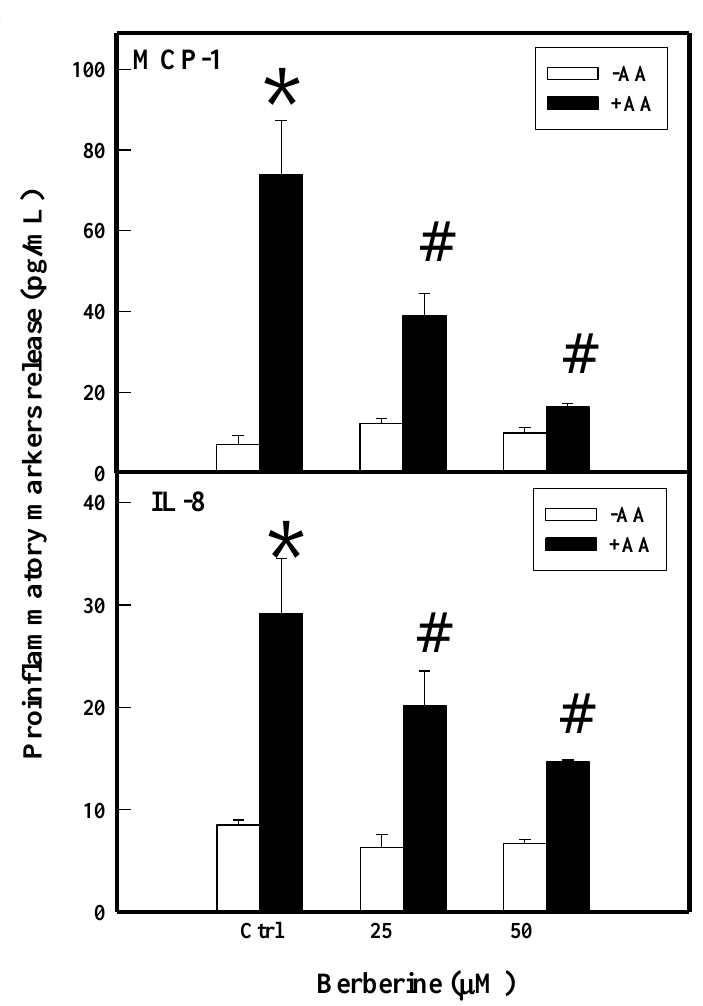
Figure 2. Effect of BBR on AA-induced COX-2 ( A ) gene transcript and proinflammatory cytokines. THP-1 cells were pretreated with BBR followed by induction with AA. At the end of the treatment, cells were centrifuged. Pelleted cells were subjected to RNA isolation and gene transcript of COX-2 assayed by RT-PCR and supernatants were assayed for proinflammatory cytokines MCP-1 ( B ) and IL-8 ( C ) by ELISA. Ctrl (control) represents cells incubated without berberine. Data represent mean ± SD of three independent experiments and # indicates p < 0.001 compared between treated and untreated with controls, * indicates p < 0.001 between the control groups.